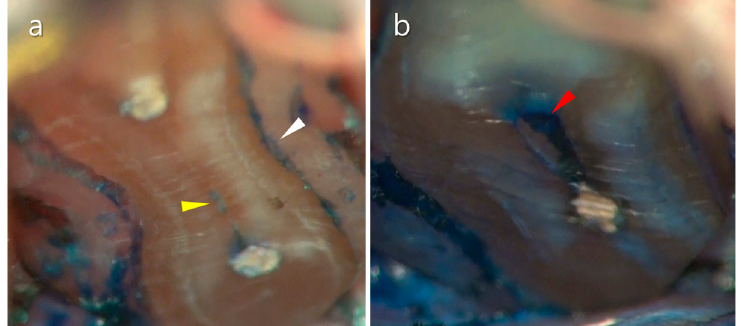
Figure 14. A resected root surface stained with methylene blue solution. ( a ) The periodontal ligament was stained and clearly distinguished from the adjacent bone (white triangle). The isthmus between the mesio-buccal and mesio-lingual canal was also stained (yellow triangle). ( b ) The stained remnant was identified in the unfilled distal root canal (red triangle).